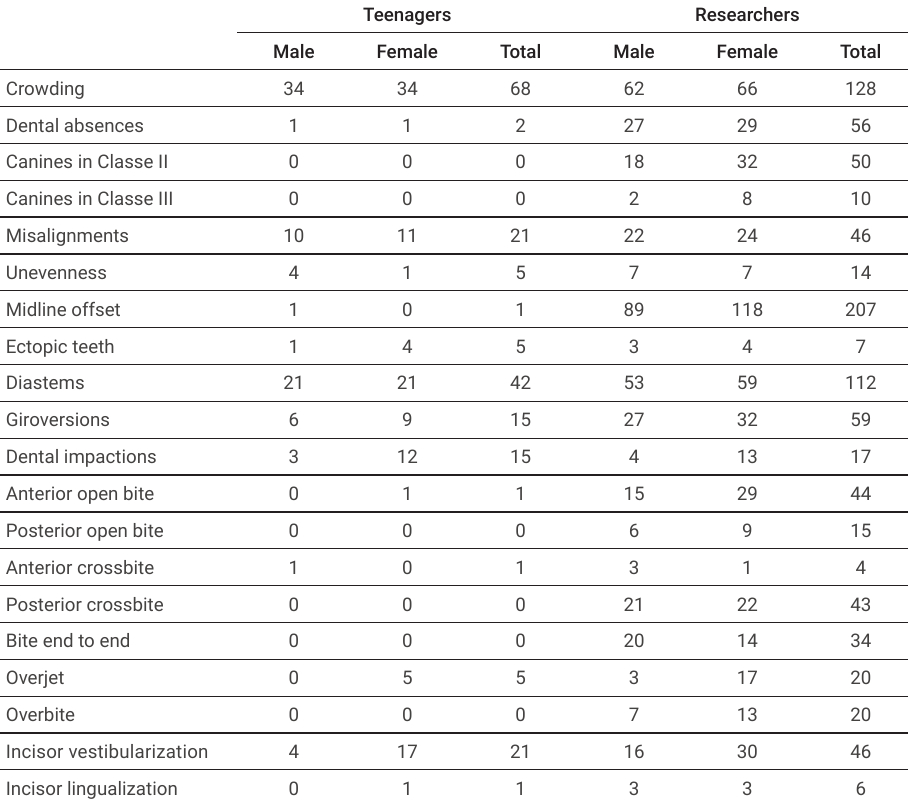
Table 1. Malocclusions observed by teenagers and researchers from March to December 2018